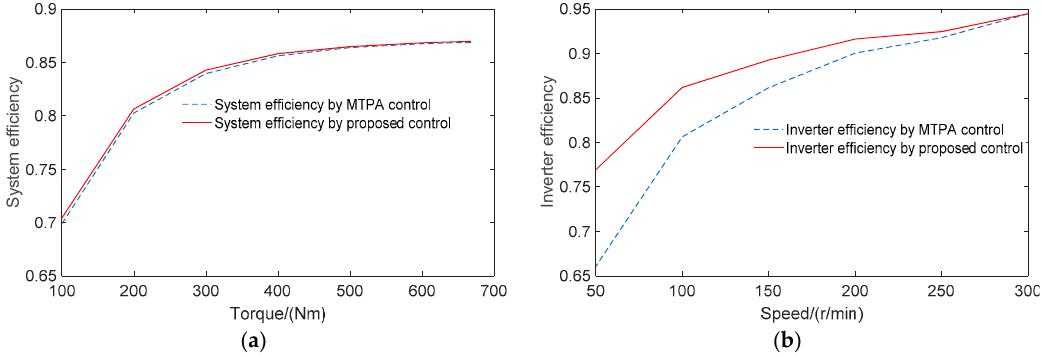
Figure 11. Efficiency optimization performance on the system efficiency by the proposed system efficiency improvement control. ( a ) System efficiency at rated speed; ( b ) system efficiency at rated torque.